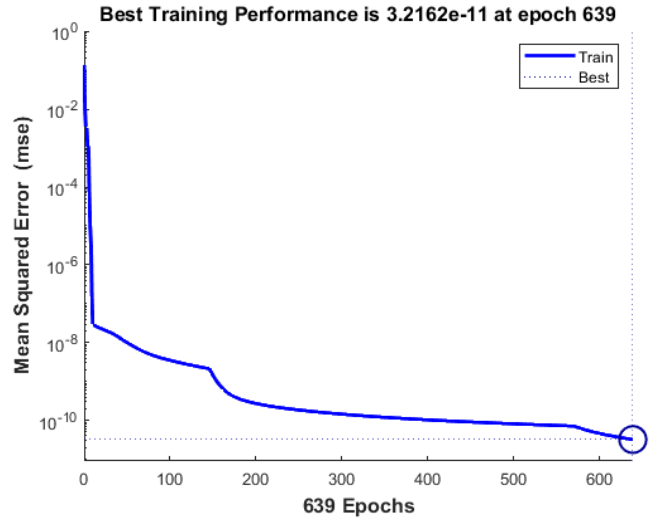
Figure 10. MSE performance training for the SARS-CoV-2 virus.